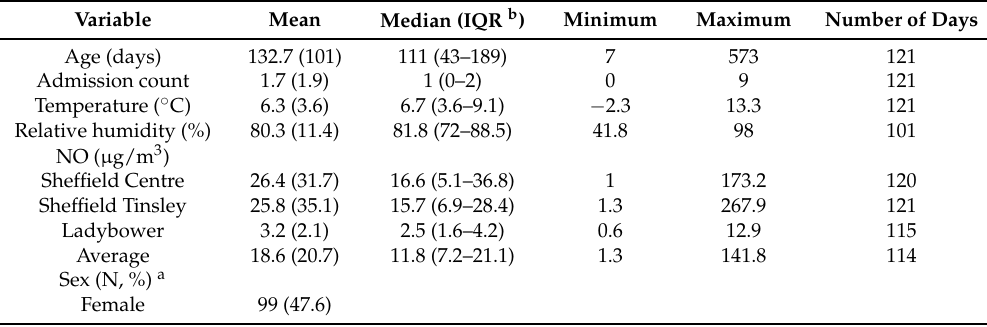
Figure 1. Average NO concentrations and RSV related admissions at Sheffield Children’s Hospital. Table 1. Summary for daily admission counts and NO concentration by monitoring